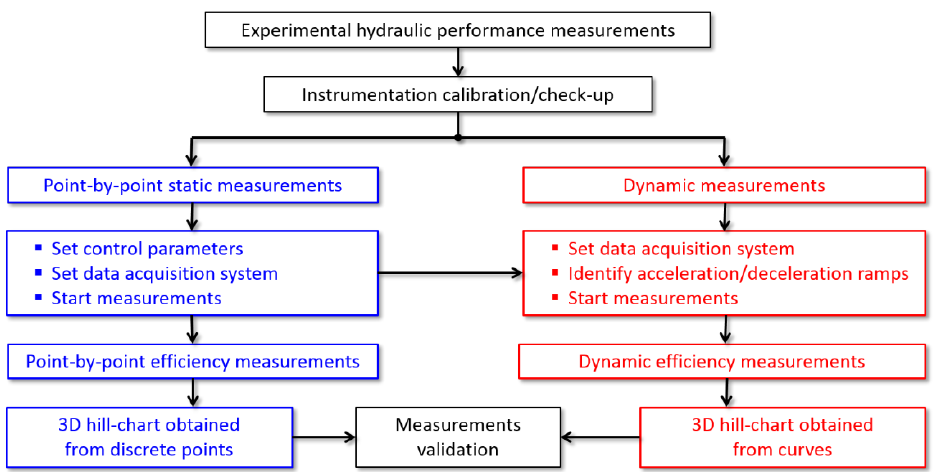
Figure 5. Flowchart of the employed experimental protocol